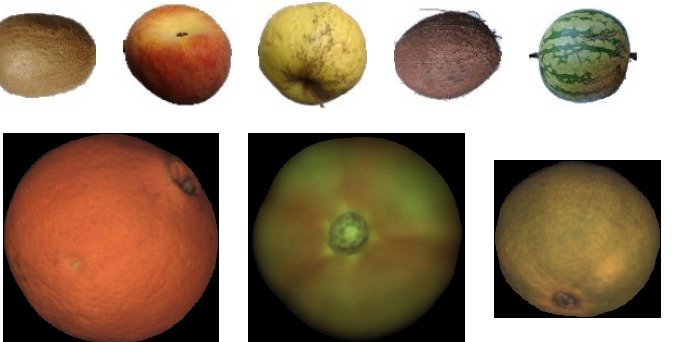
Figure 19. Top : Sample Images from Fruits-360 data set; from left to right kiwi, peach, apple golden, coconut, and watermelon; Bottom : Sample Images from FruitRot3D dataset; from left to right, orange, tomato, and